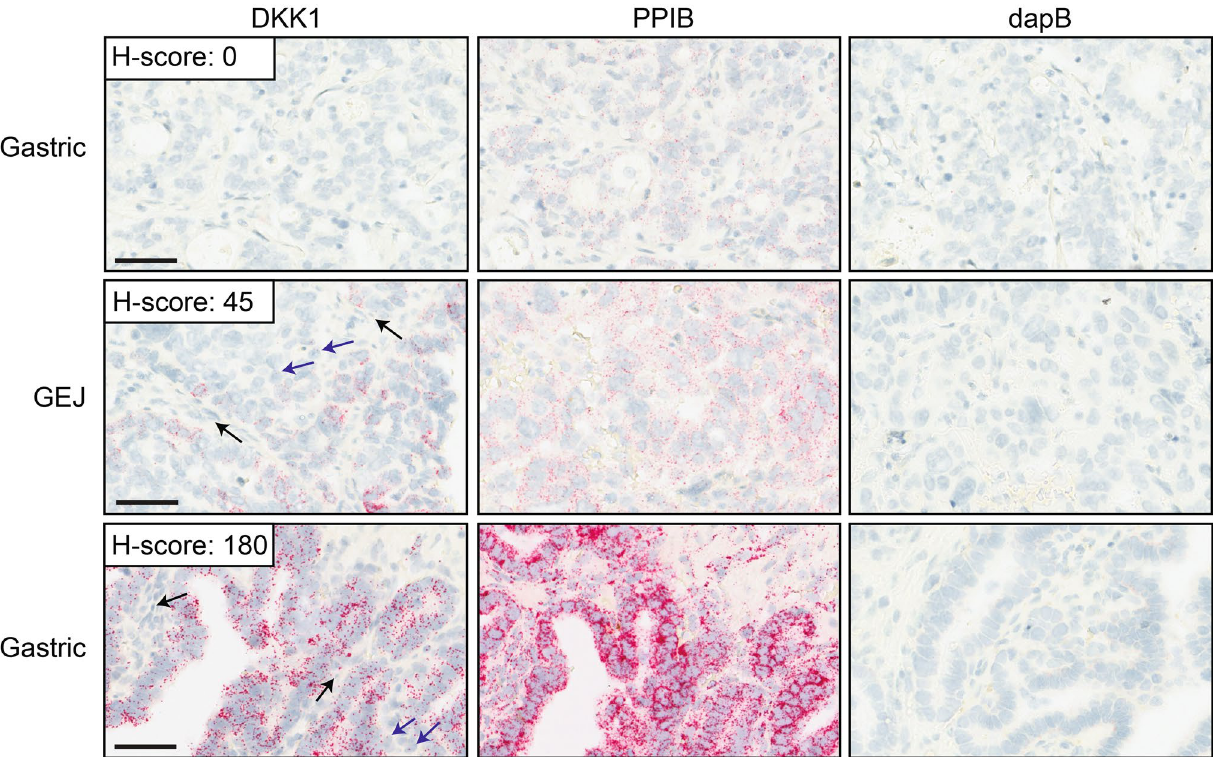
Figure 3. The DKK1 RNAscope assay in tumor resections. Representative images from 3 tumor resections with no (top row), moderate (middle row) and high (bottom row) DKK1 signal are shown with the PPIB control for RNA integrity and the dapB background control. DKK1 H-scores (range 0–300) were semi-quantified manually as described in the methods. Black arrows denotes non tumoral cells without DKK1 signal. Blue arrows denote tumor cells with low levels of DKK1 signal (one dot per cell). Scale bar: 50